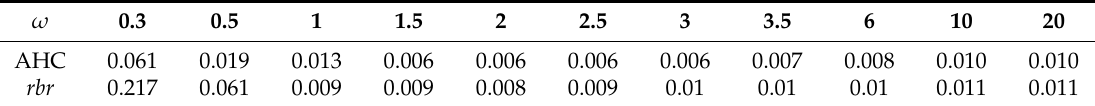
Table 1. Error rate with various ω values.